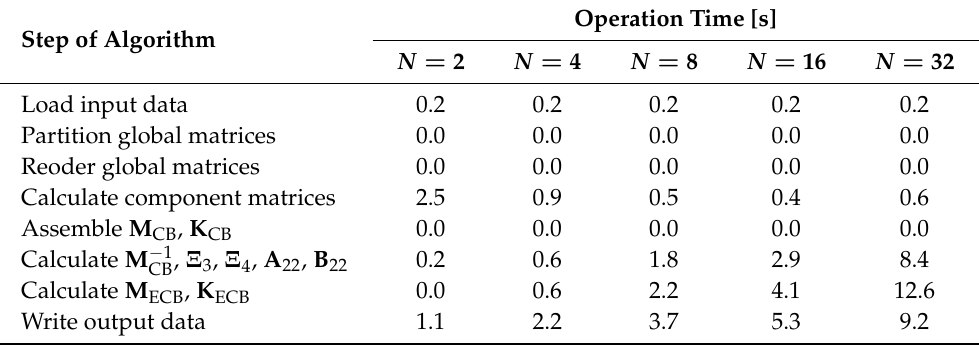
Table 1. Operation time at each step of the algorithm in the cylindrical shell